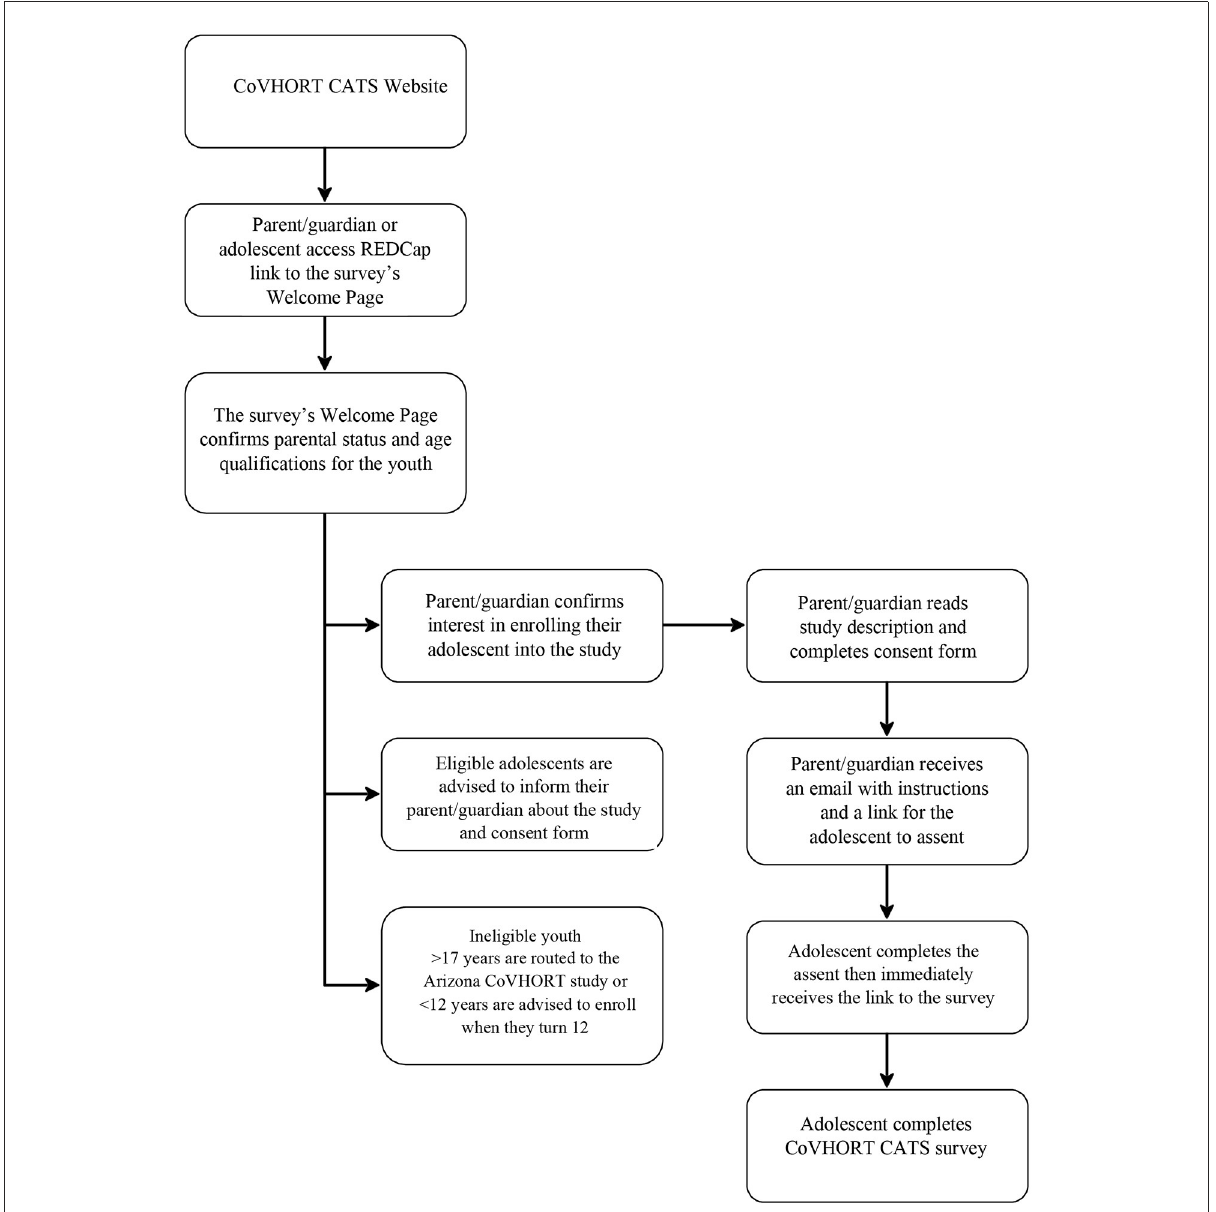
FIGURE1 CoVHORT CATS procedural flow